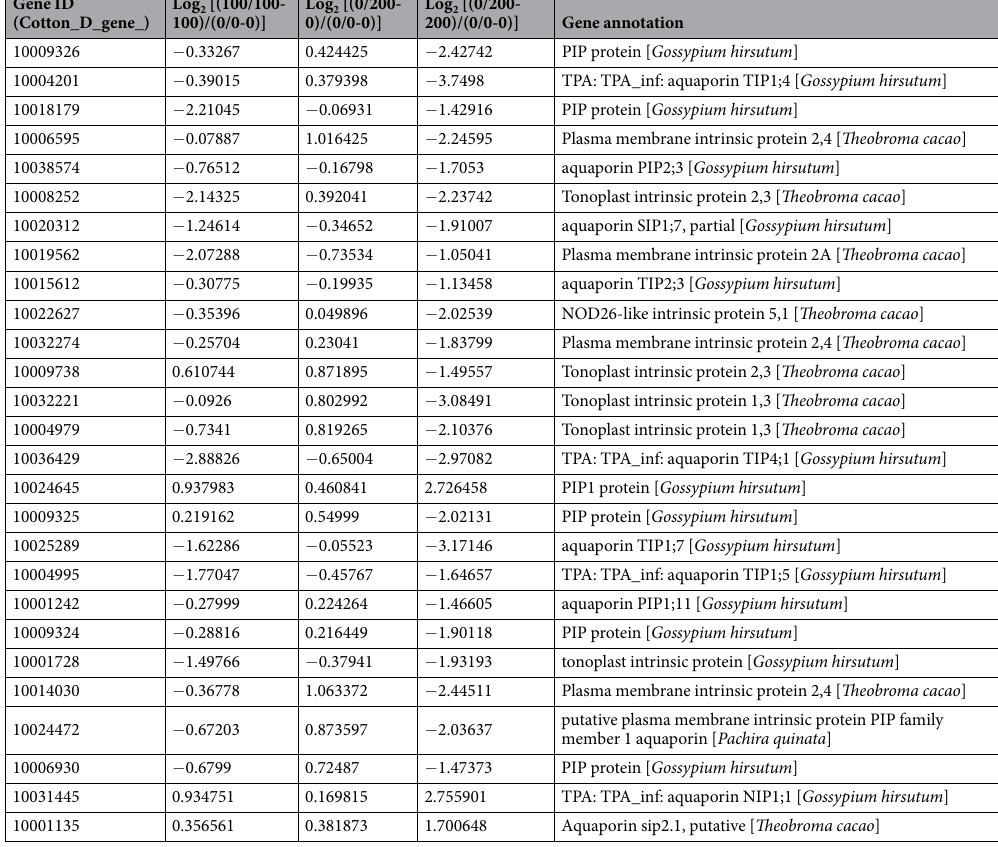
Table 3. The expression patterns of aquaporin genes in roots under uniform and non-uniform salinity treatments, which were significantly up- or down-regulated in the high-saline root